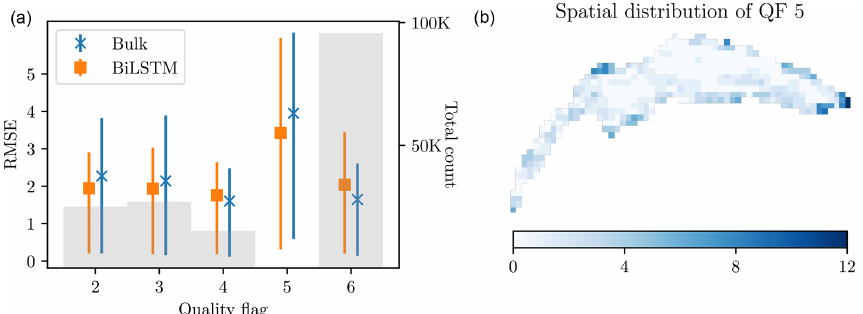
Figure 12. Analysis of BiLSTM performance in the DA run with respect to the different quality flags. (a) LSWT difference with respect to bulk temperature (in blue) and BiLSTM predictions (in orange) as a function of QF. The faint gray bars show the total number of LSWT measurements associated with the QF. (b) Spatial distribution of LSWT measurement availability for QF 5.